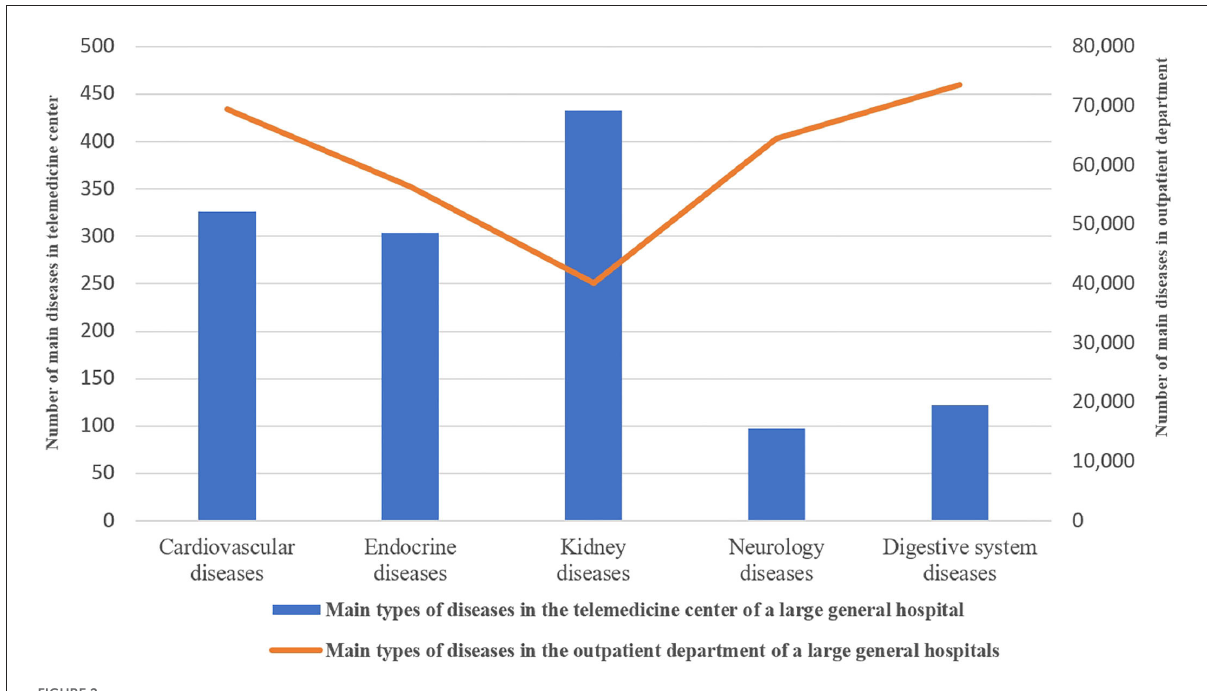
FIGURE2 Differences between the main diseases of the elderly applying medical services via the new telegeriatrics system and the elderly outpatients in a university-affiliated hospital.